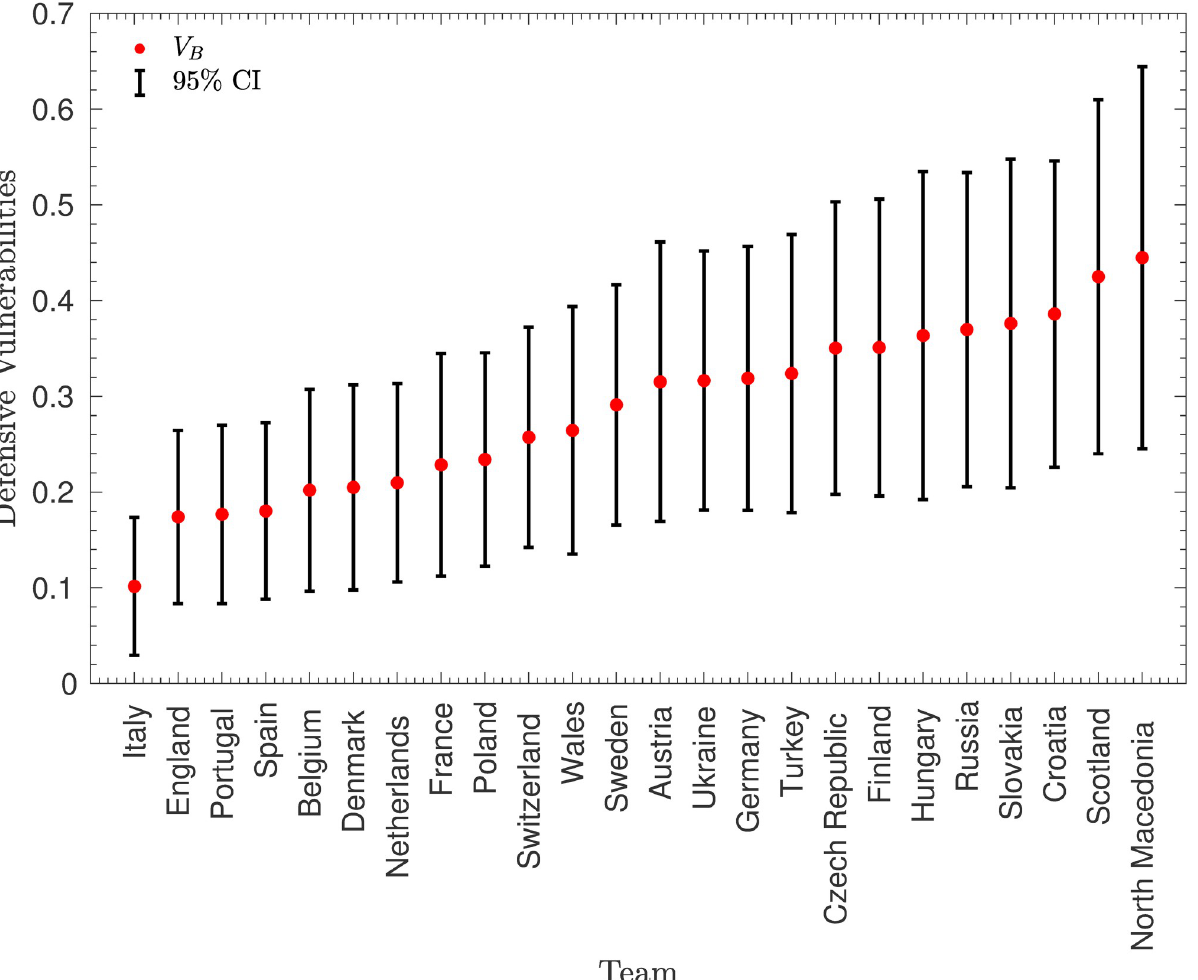
Fig 7. Confidence intervals for the V B parameters. Approximate 95% confidence intervals for the defensive vulnerabilities, V B of the teams playing in Euro